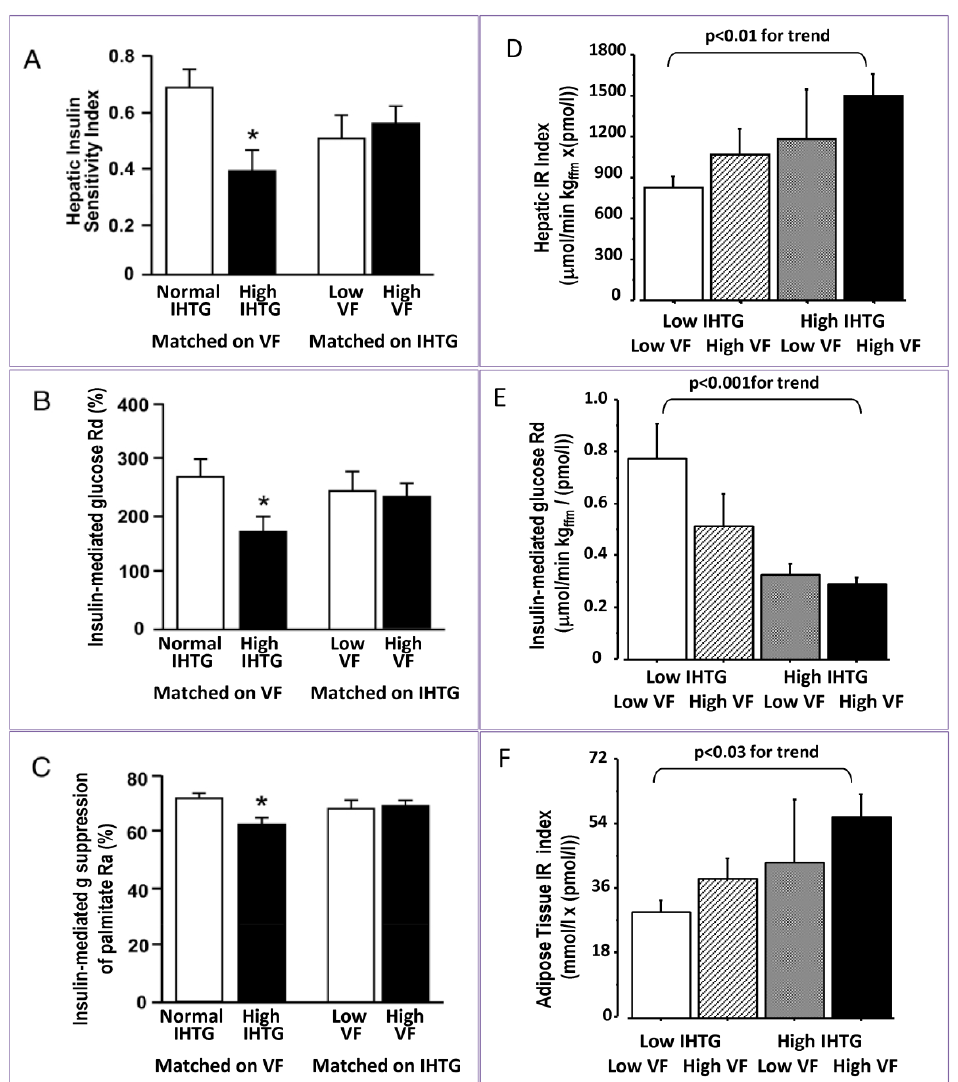
Figure 2. Right panel: Insulin resistance at the level of liver, muscle and adipose tissue is increased proportionally to both IH-TG and VF. Data redrawn from [7]. Average data for IH-TG and VF are shown in Table 1. Left panel: Subjects with similar but high VF (~1.3 kg) had increased insulin resistance if they had high IH-TG (~25%) compared to subjects with low IH-TG (4%) [12]. However, when matched per IH-TG (~13%), subjects with low and high VF had comparable indexes of insulin resistance (reproduced with permission from